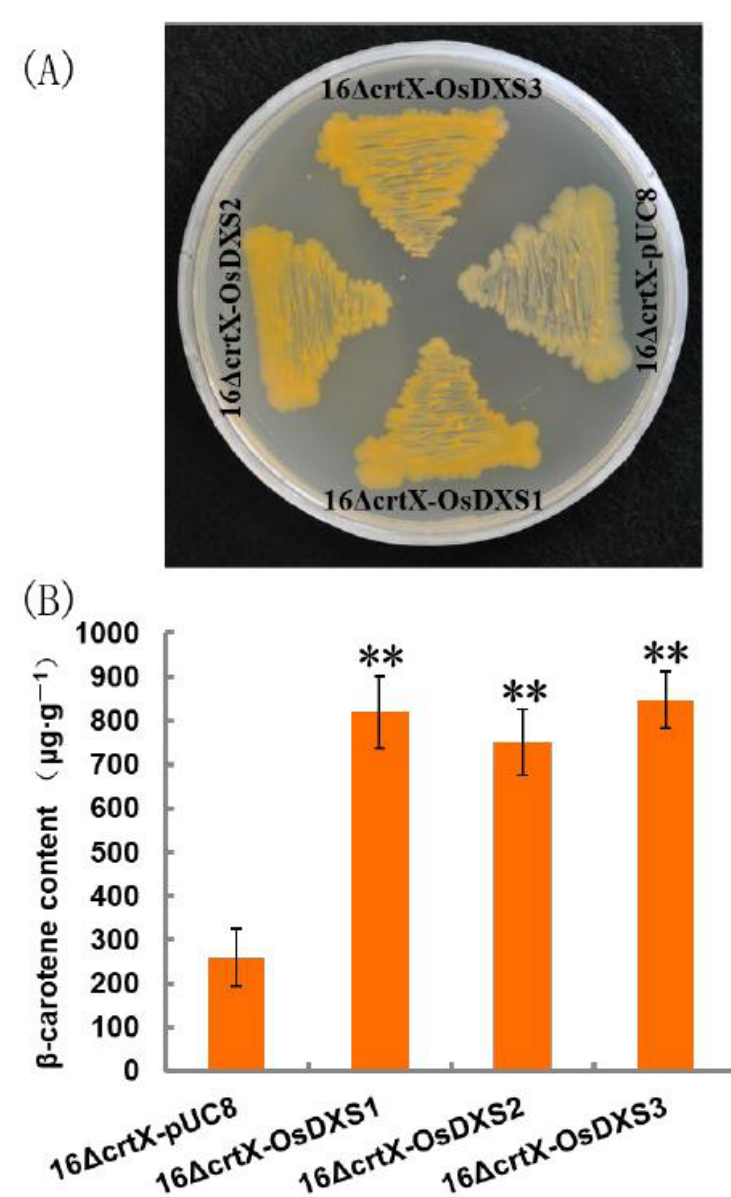
(Figure 2B). The results indicated that OsDXS1 and OsDXS2 were similar to OsDXS3, encoding functional DXS activities.